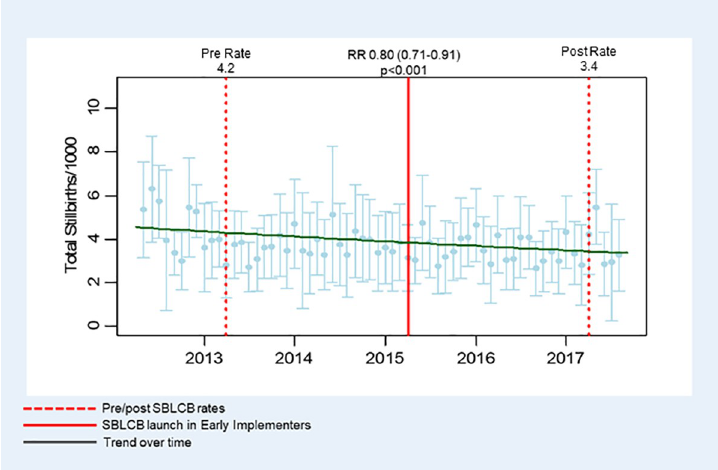
Fig 1. Average total stillbirth rate across participating sites. Comparison between pre and post implementation of the Saving Babies Lives care bundle demonstrates a reduction between pre- and post-implementation periods. Republished from Saving Babies’ Lives Project Impact and Results Evaluation (SPiRE): A mixed methodology study under a CC BY license, with permission from the University of Manchester, original copyright 2018.